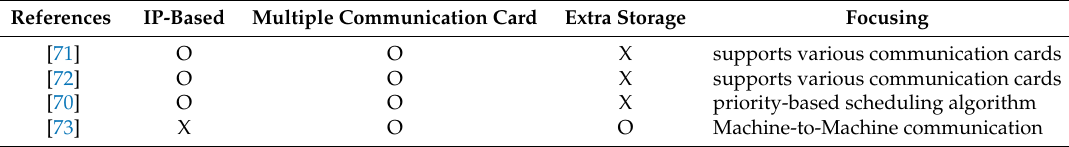
Table 5. The technological comparison of IoT